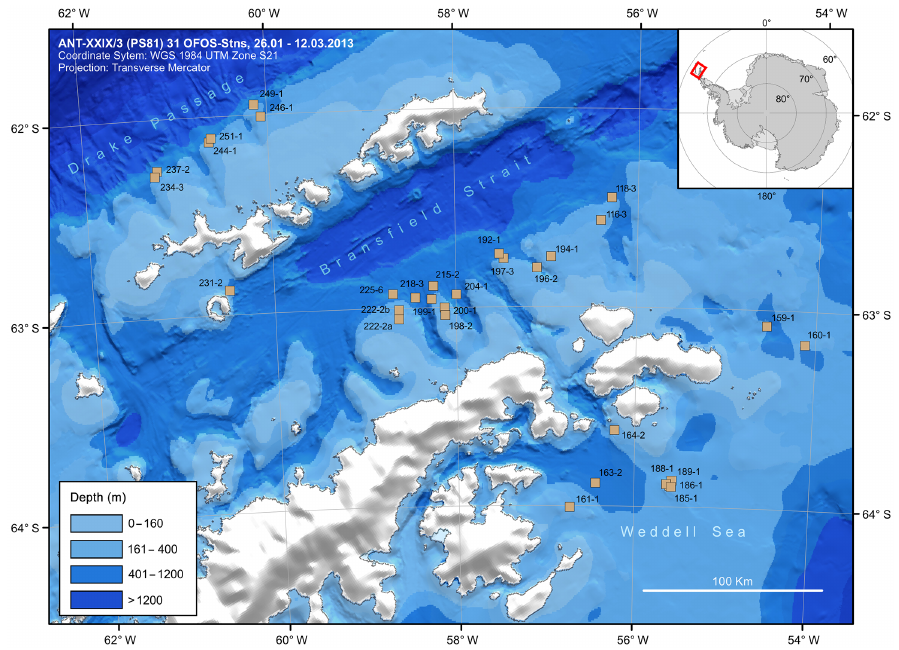
Figure 2. Map of the geographic positions of the stations at which seabed photographs were taken by means of OFOS along photographic transects in three regions (Weddell Sea, Bransfield Strait, and Drake Passage) off the northern Antarctic Peninsula during Polarstern cruise ANT-XXIX/3 (PS81) from January to March 2013.